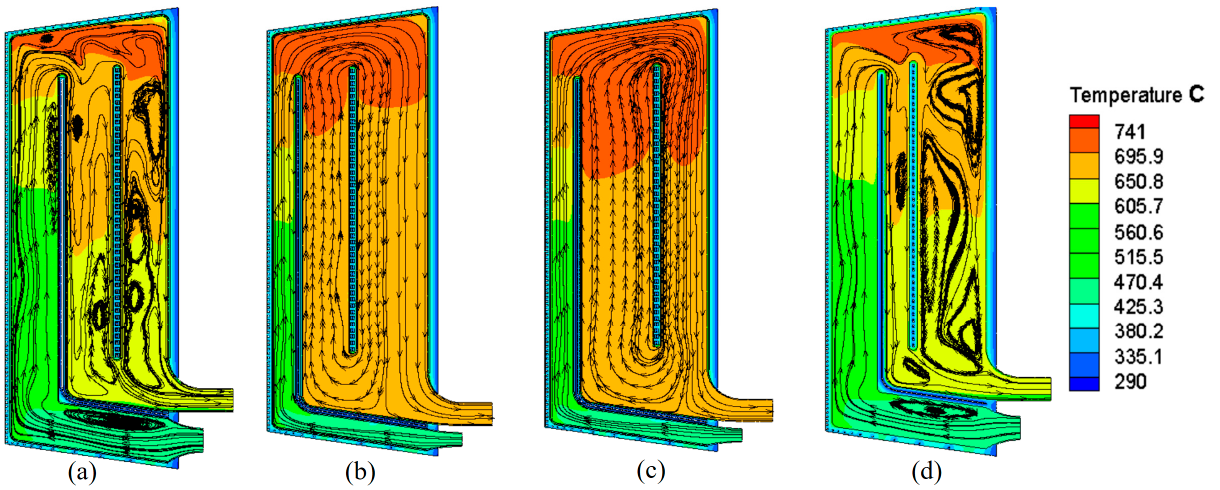
Figure 18. Temperature field combined with streamline ( a ) 1:1:1; ( b ) 0.5:1:1.5; ( c ) 0.5:1.5:1; ( d )1:0.5:1. Table 6. Results summary of the four designs.